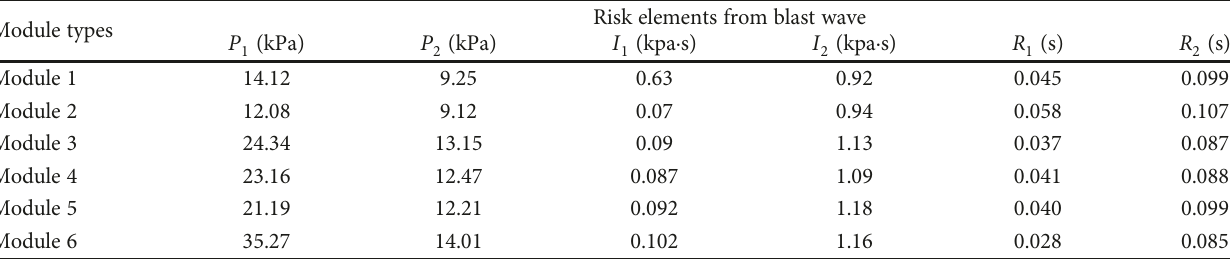
Table 3: The consequence for risk elements of blast wave in each module.